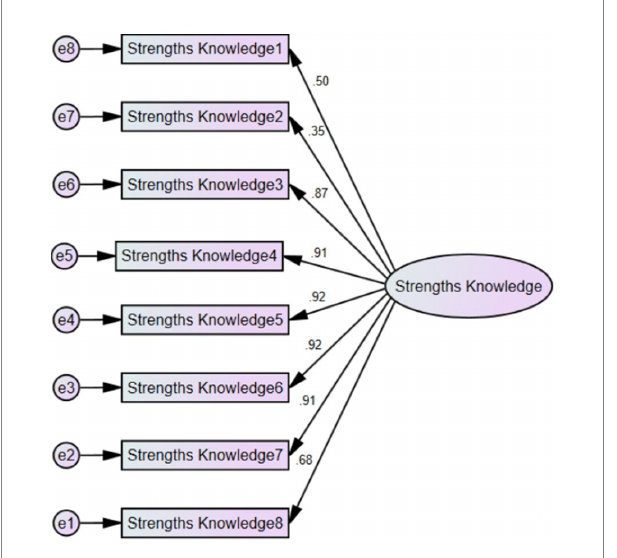
FIGURE 2 Factorial Structure of the Spanish version of the strengths Knowledge scale (study 2).